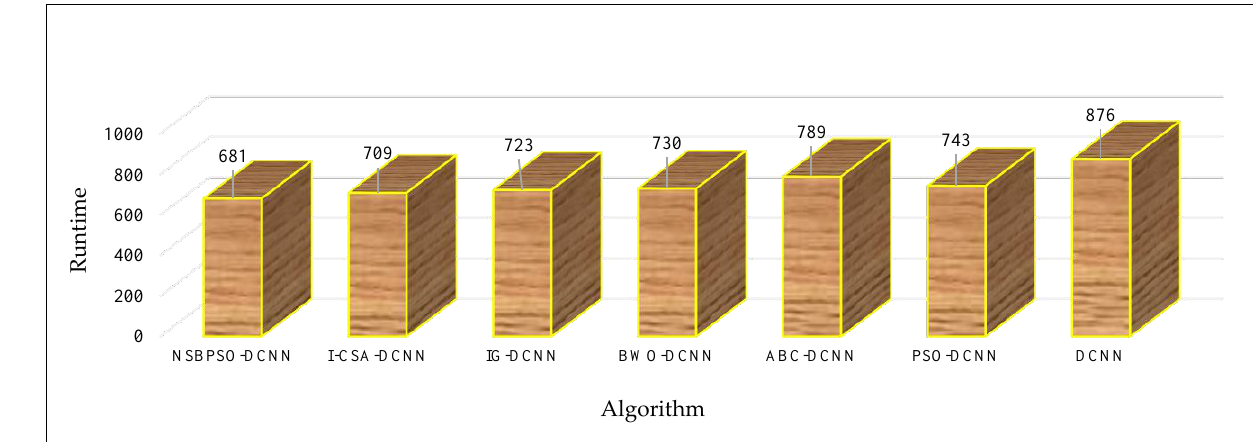
Figure 10. Comparison of the proposed algorithms.